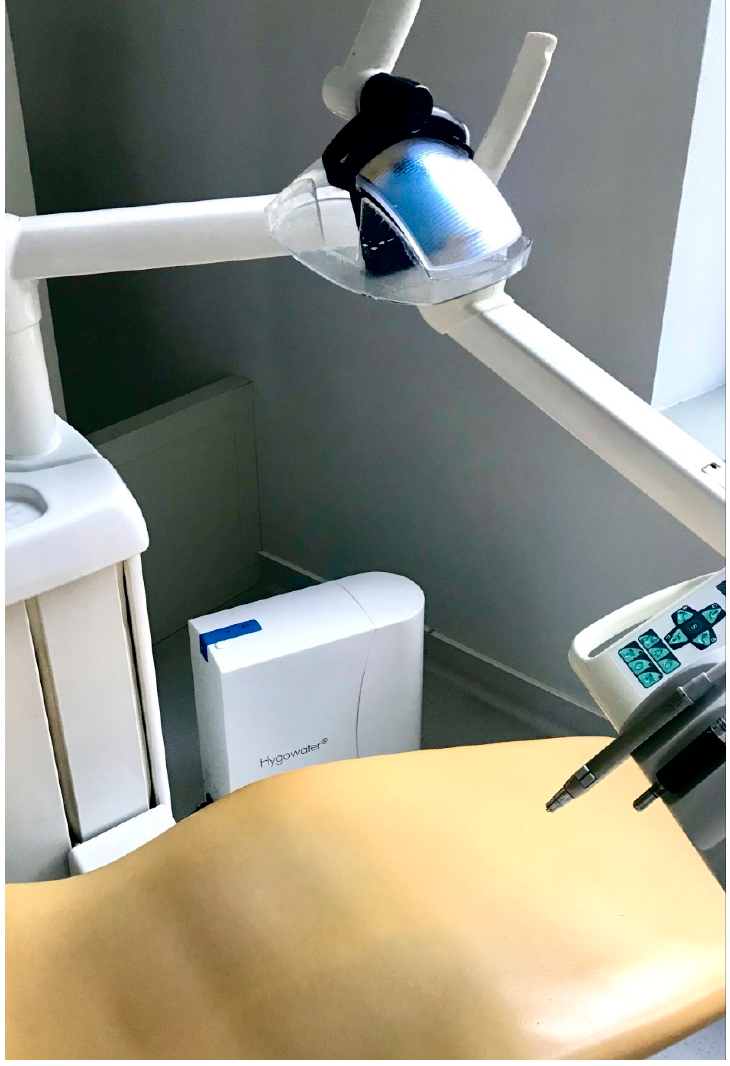
Figure 1. Hygowater ® system, connected to a dental